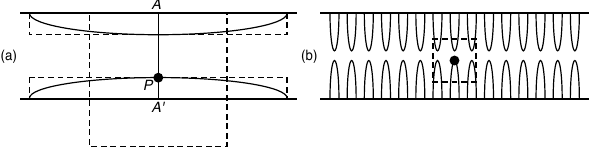
Figure 12. Channel domain sections: (a) thin foils and (b) thick foils.